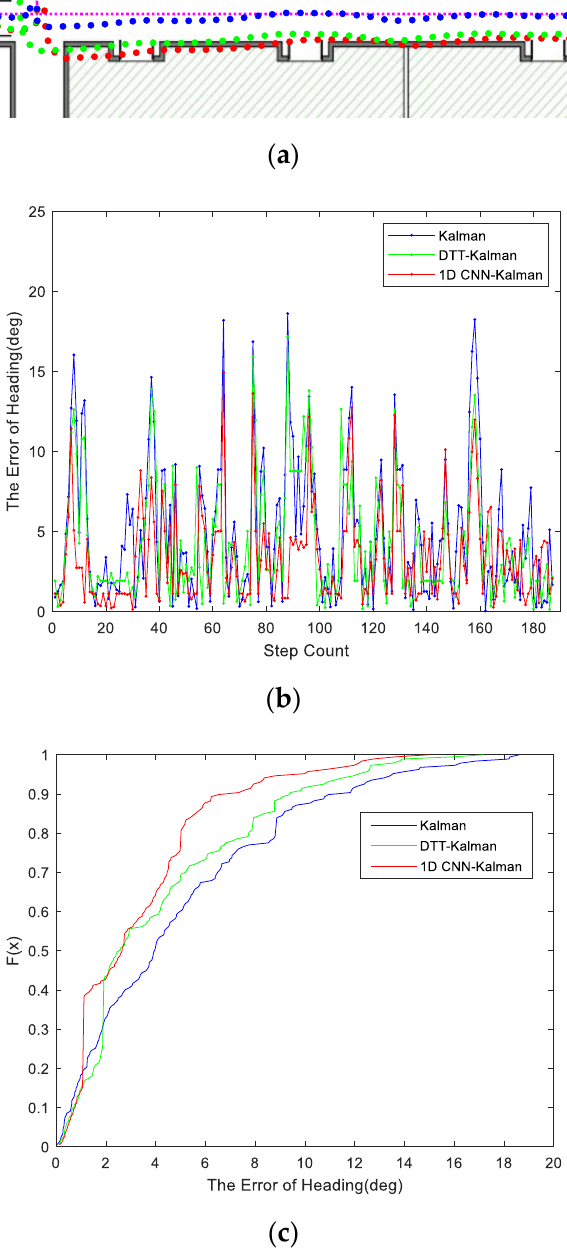
This paper proposes an indoor pedestrian navigation algorithm that can significantly improve navigation accuracy using magnetic data. Based on the CNN network, we designed an unsupervised learning model and obtained an algorithm that can screen out anomalies in indoor magnetic data